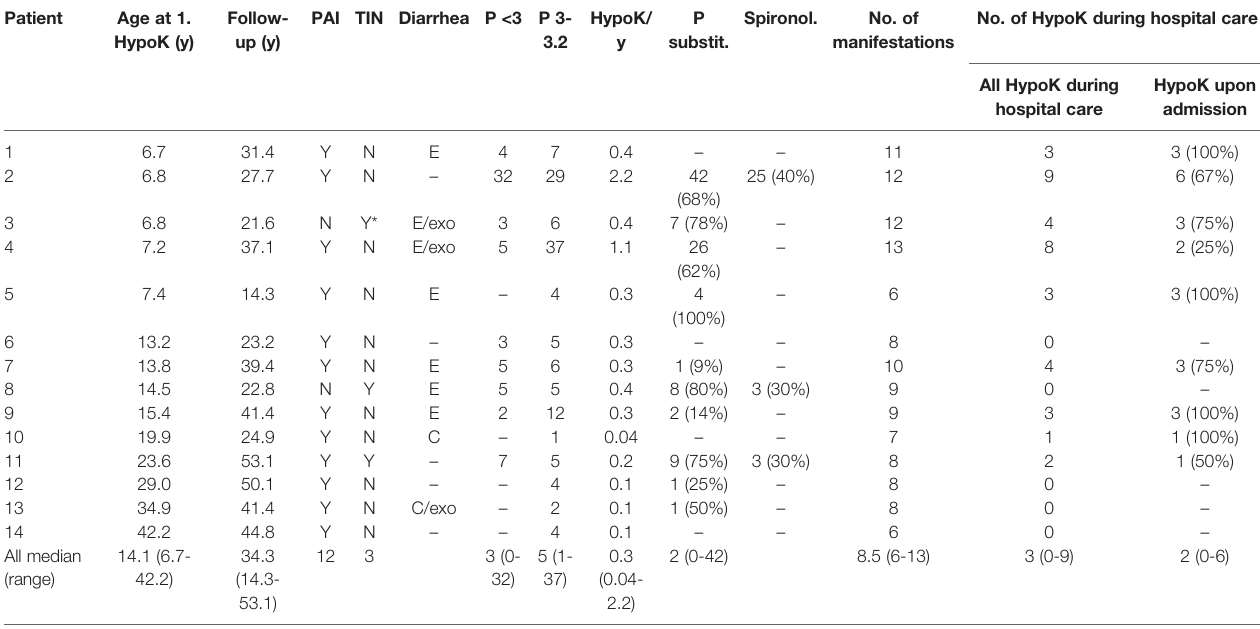
TABLE 1 | Table showing details on hypokalemic periods (HypoK) in 14 patients with APECED. Patient Age at 1. HypoK